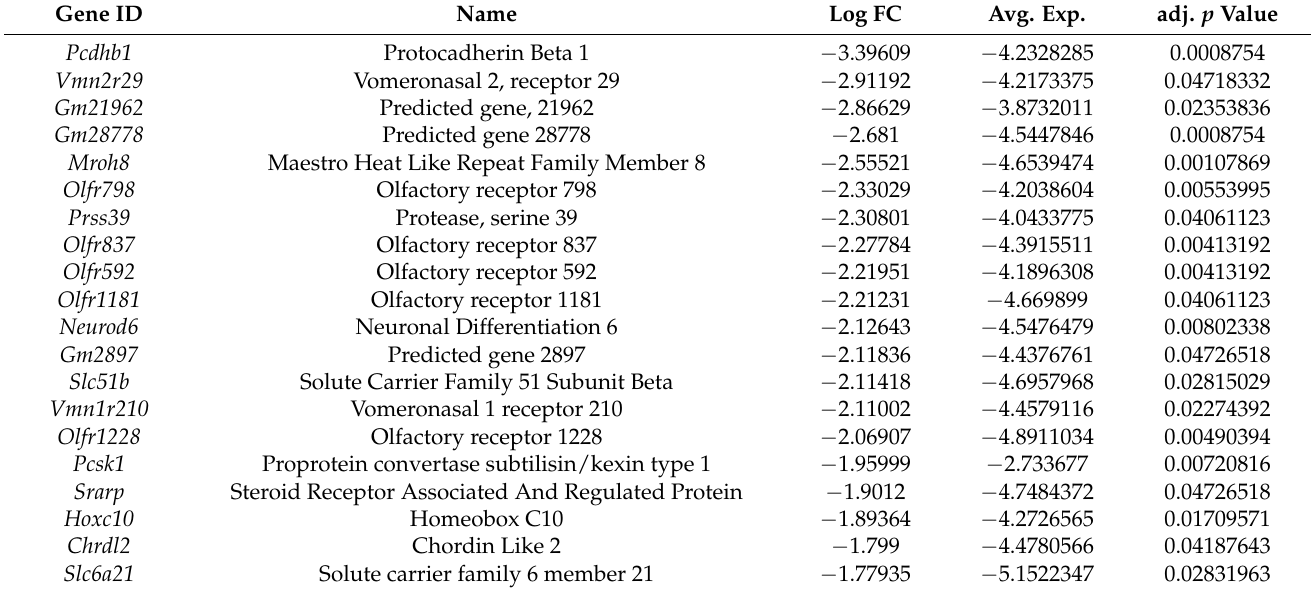
Table 1. Top 20 downregulated genes in BSp-treated breast tumor samples vs. control tumor samples. For both groups n = 7 mice and significance cutoff was an adjusted p value < 0.05.